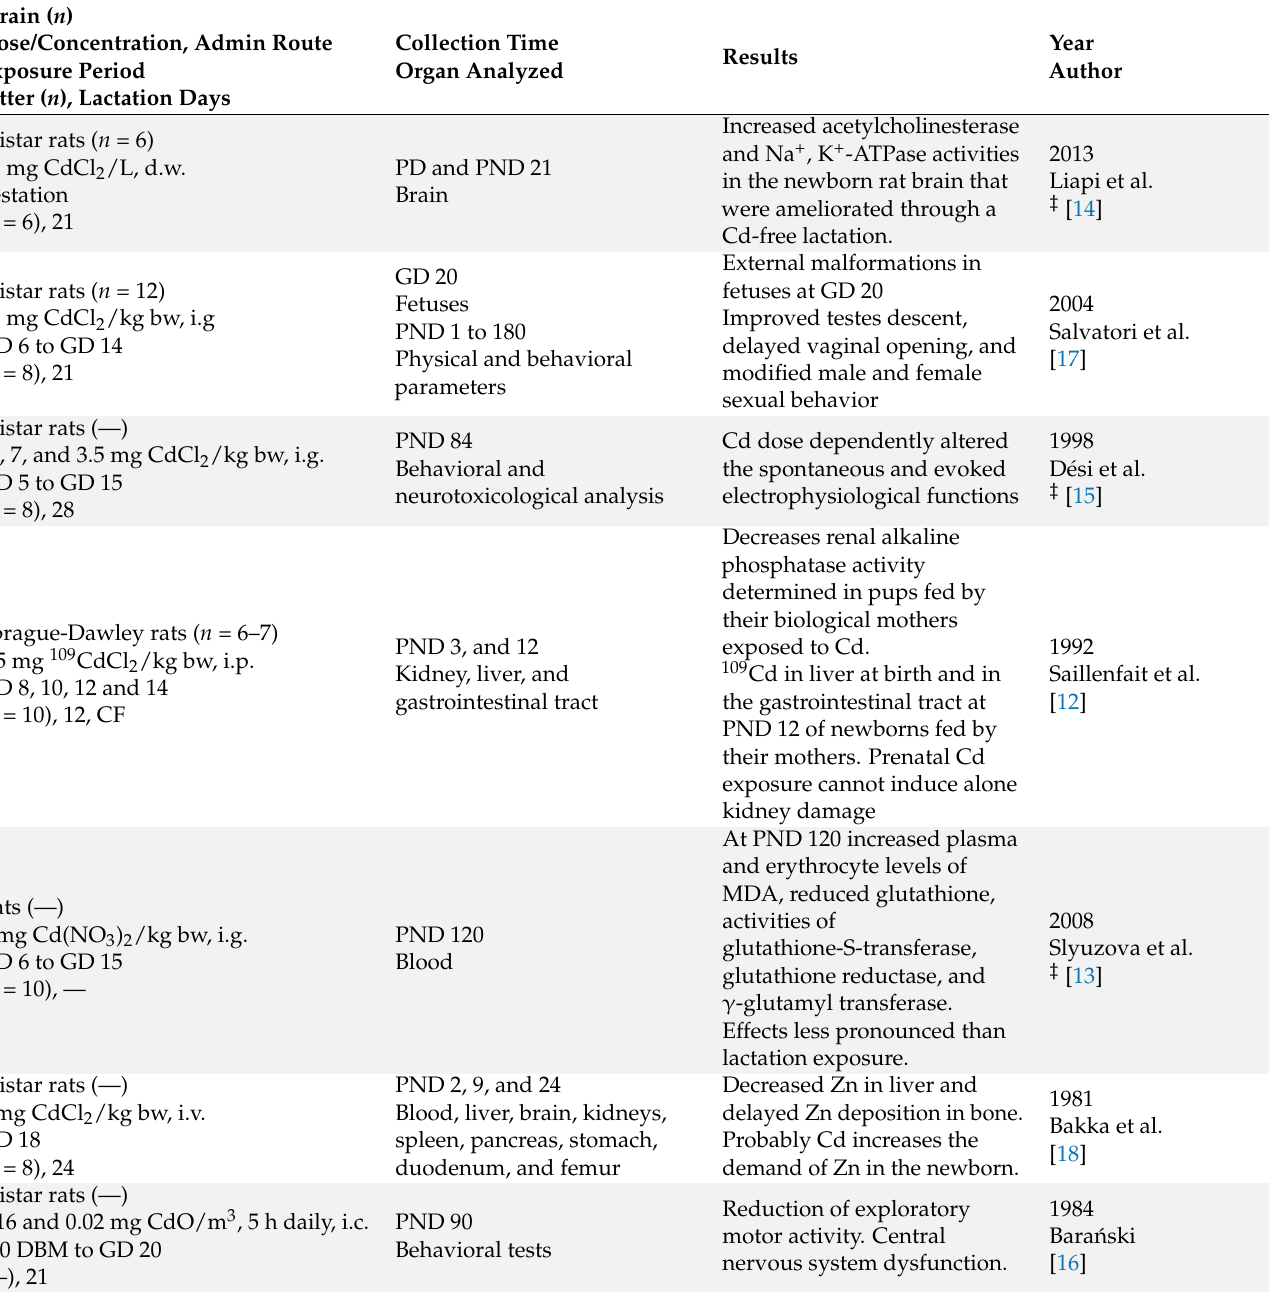
Table 1. Cd exposure during pregnancy period. Data ordered by dose/concentration of Cd adminis- tered to